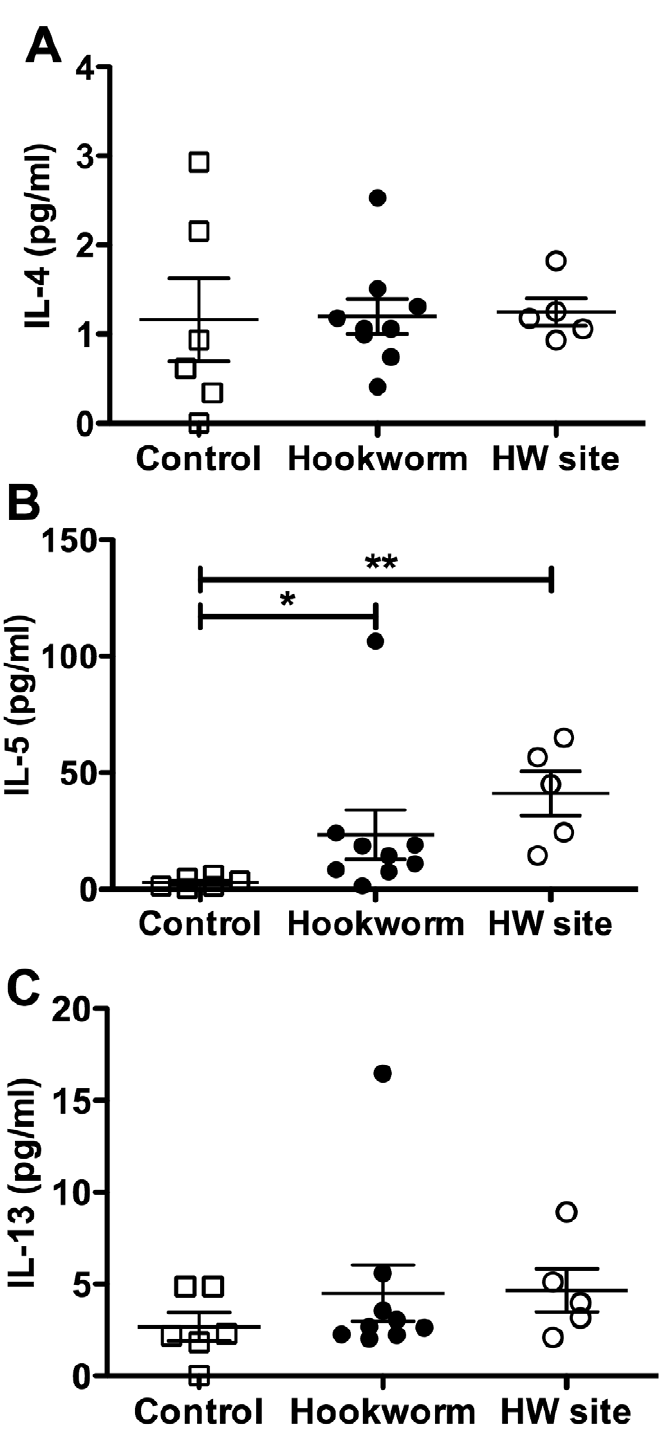
Figure 3. Production of Th2 cytokines in the duodenal mucosa of hookworm infected individuals. Duodenal biopsies from Trial 1, taken from either the duodenum at week 20 post-infection or from directly adjacent to an adult hookworm attachment site (HW site – determined by endoscopy) at week 21 in the hookworm group only, were cultured for 24 h in tissue culture medium at 37 u C with 95% O 2 /5% CO 2 . Cell supernatants were removed and levels of IL-4 (A), IL-5 (B) and IL-13 (C) were determined using a Cytometric Bead Array. Data were analysed by Mann-Whitney U test. doi:10.1371/journal.ppat.1002520.g003 increased levels of IL-5 were produced by biopsy cells from increased levels of IL-5 at the hookworm attachment sites were not hookworm-infected individuals, especially those biopsies taken the result of gluten challenge, because at week 21, biopsies from adjacent to the hookworm attachment site (Figure 3B). The sites distal to the hookworm attachment sites produced decreased